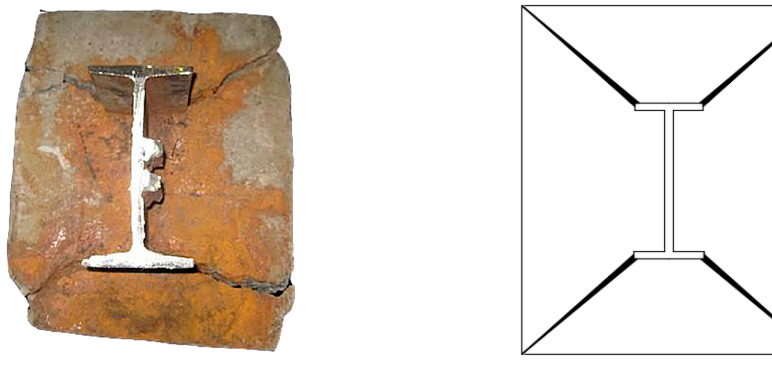
Figure 6. Typical crack patterns at loading ends.